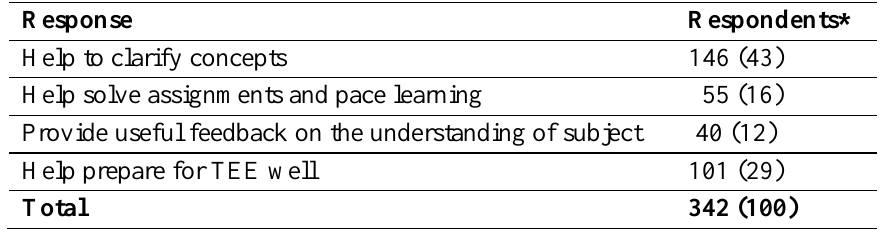
Ways Learners Found Self-Assessment Questions